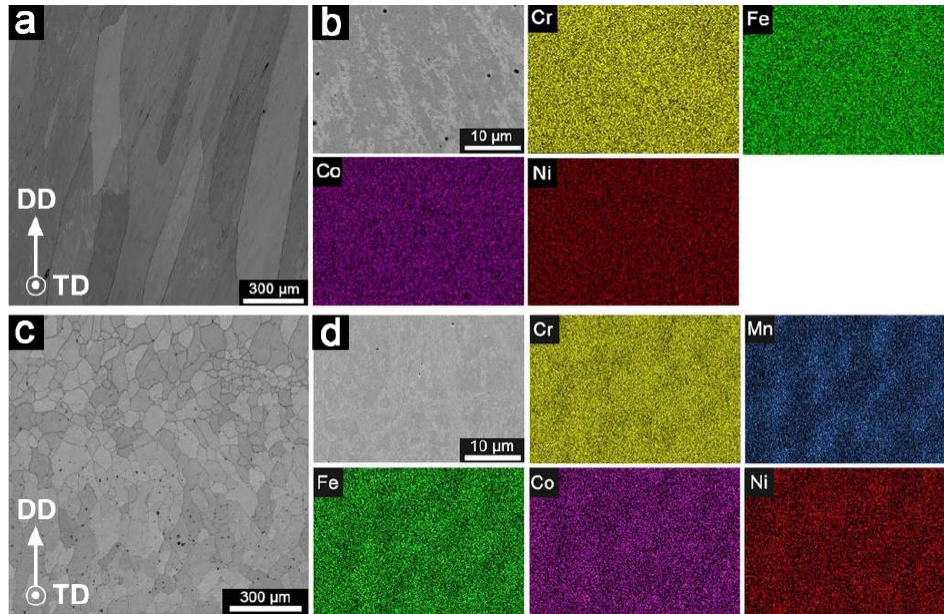
Figure 3. EDS maps of ( a , b ) CoCrFeNi and ( c , d ) CrMnFeCoNi samples prepared via DED.